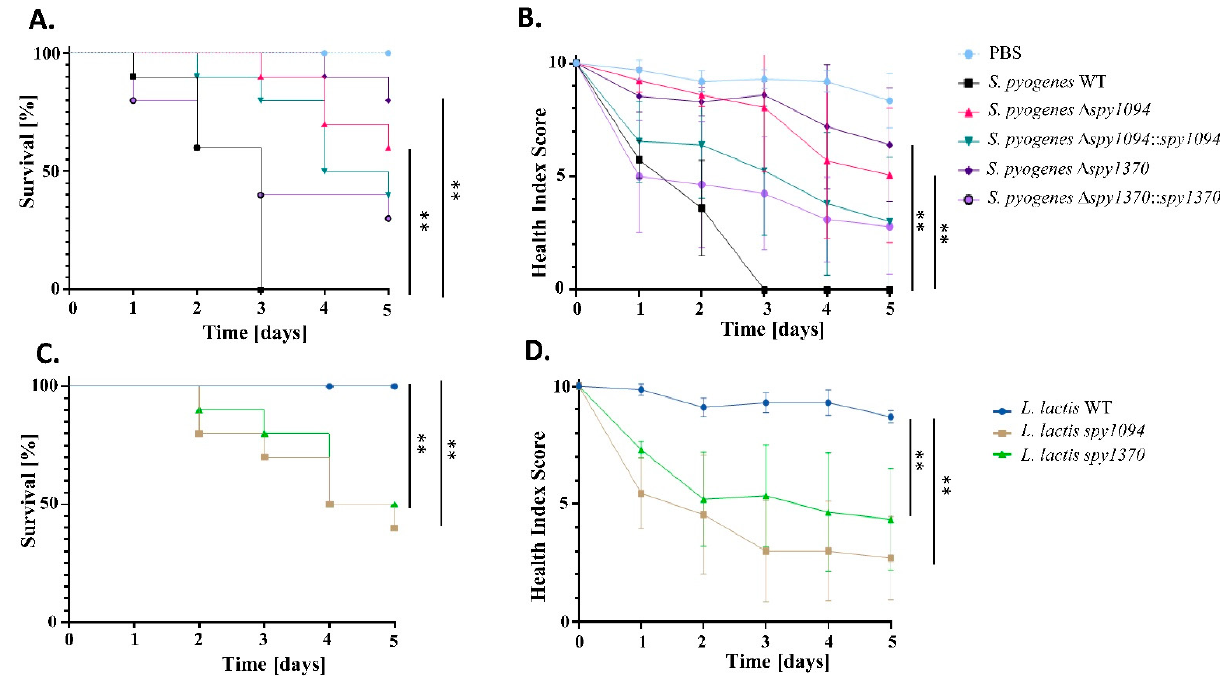
Figure 7. Infection of G. mellonella larvae shows a role for Spy1094 and Spy1370 in S. pyogenes virulence. Twenty microlitres of bacteria (1.5 × 10 6 CFU for S. pyogenes wildtype and mutant strains and 1 × 10 5 CFU for L. lactis wildtype and mutant strains) were injected into the lower left proleg of G. mellonella larvae ( n = 10). A control group was injected with sterile PBS only. Survival of the larvae was monitored over a 5 ‐ day period post ‐ injection. ( A ) S. pyogenes wildtype and mutants. ( C ) L. lactis wild ‐ type and mutants. In addition, a health index score was calculated which includes mobility, cocoon formation and melanisation of the infected larvae. ( B ) S. pyogenes wildtype and mutants. ( D ) L. lactis wild ‐ type and mutants. P values were calculated using the one ‐ way ANOVA tests. ** p < 0.001.